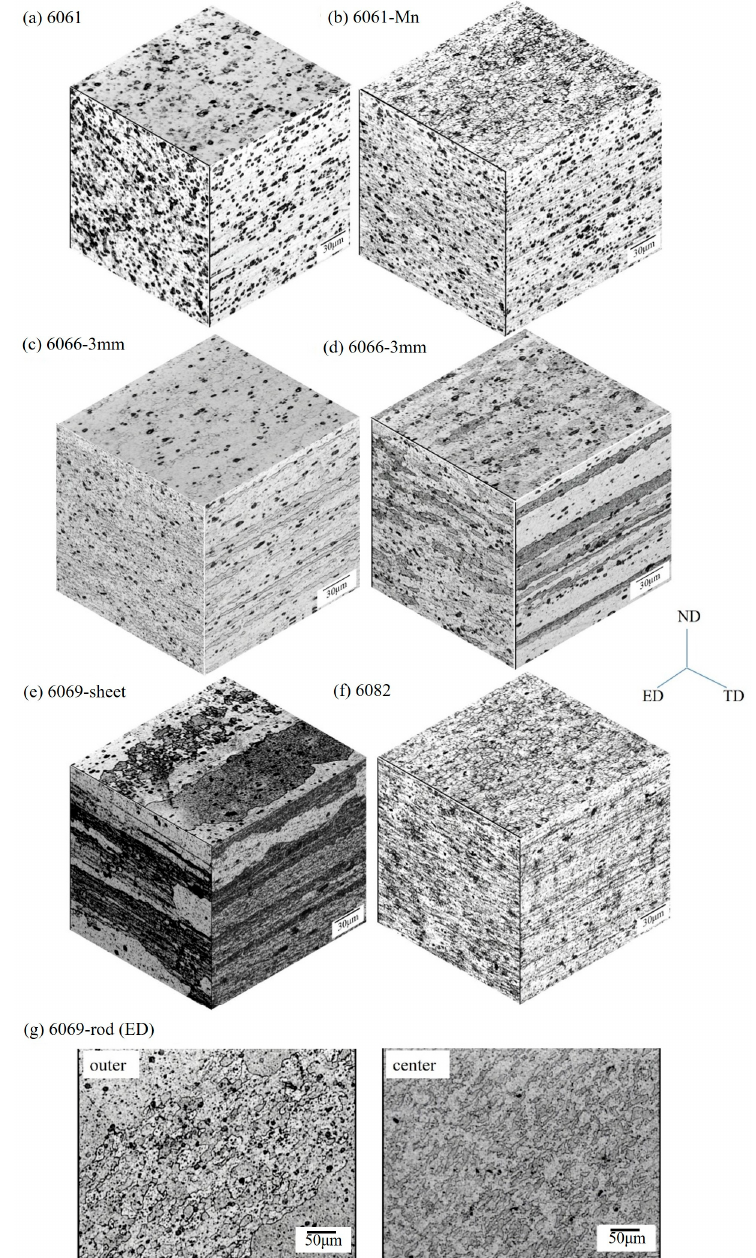
Figure 3. Microstructures of extruded Al–Mg–Si alloys. ( a ) 6061; ( b ) 6061-Mn; ( c ) 6066-3mm; ( d ) 6066-9mm; ( e ) 6069-sheet; ( f ) 6082 and; ( g ) 6069-rod.